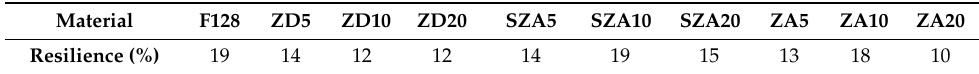
Figure 3. Resilience of the tested materials.